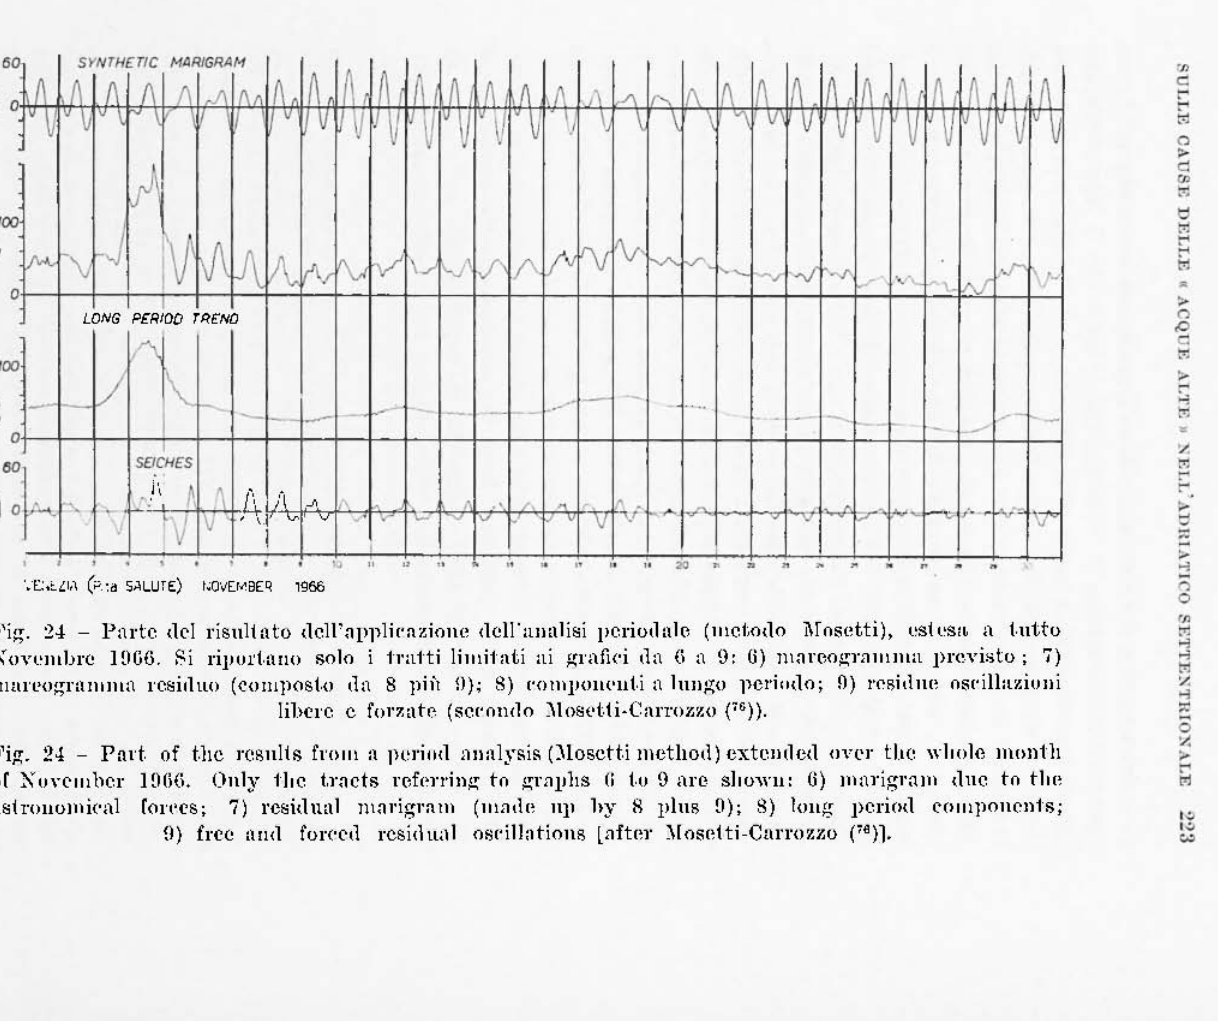
Fig-. 24 - Pnrtc deI risultatu dcll':lpplil'azione (lelLlIlalisi pcriU(lale (metodo ì\rosetti), t'stesa n luttu Noyt'mbre IDGG, Si ril)ol't.ano solo i tratti limitati ai I!:l'nlki dn (i n U: 6) 1l\:lHlOl!;l"il1l1111H prcyisto; 7) lllHl'l'og-nlllllwl l'CSillilo (COlllpost,o dn 8 più H); S) ('OlllIH)Jl{·Ut.j n lungo periodo; fl) l'l'si,!ne oSl'illazÌoui lihere c fOI'1.at" (scl'olH10 ~1()sd,ti.CalTozzo ('G)}. }<'ig. 24 - Pari. of t.hc resnlls f\'OlI! il ]I('l"io(1 :lIlaly~i~ C'loscHi lllctholl) cxtl~ll(lcd uve]" thc wllOlc llIonth or XoyC'mbcr l[)()(i. 01l1y 11lc j,l":lcts refpl"l'ing: to g:rillJhs n j.o gare sllUwu: 6) lllnrigl'alll dlle to tll(~ astrollulllÌ('nl ron'es; 7) residua! ll\:ll'igram (m,Hle n}1 hy 8 plns D); 8) loug- pcrÌod componenls; D) frce [\!1(1 fon'cd rcsÌlhwl o8eil!:Jtions [,liter :\Iosetti-Carrozzo